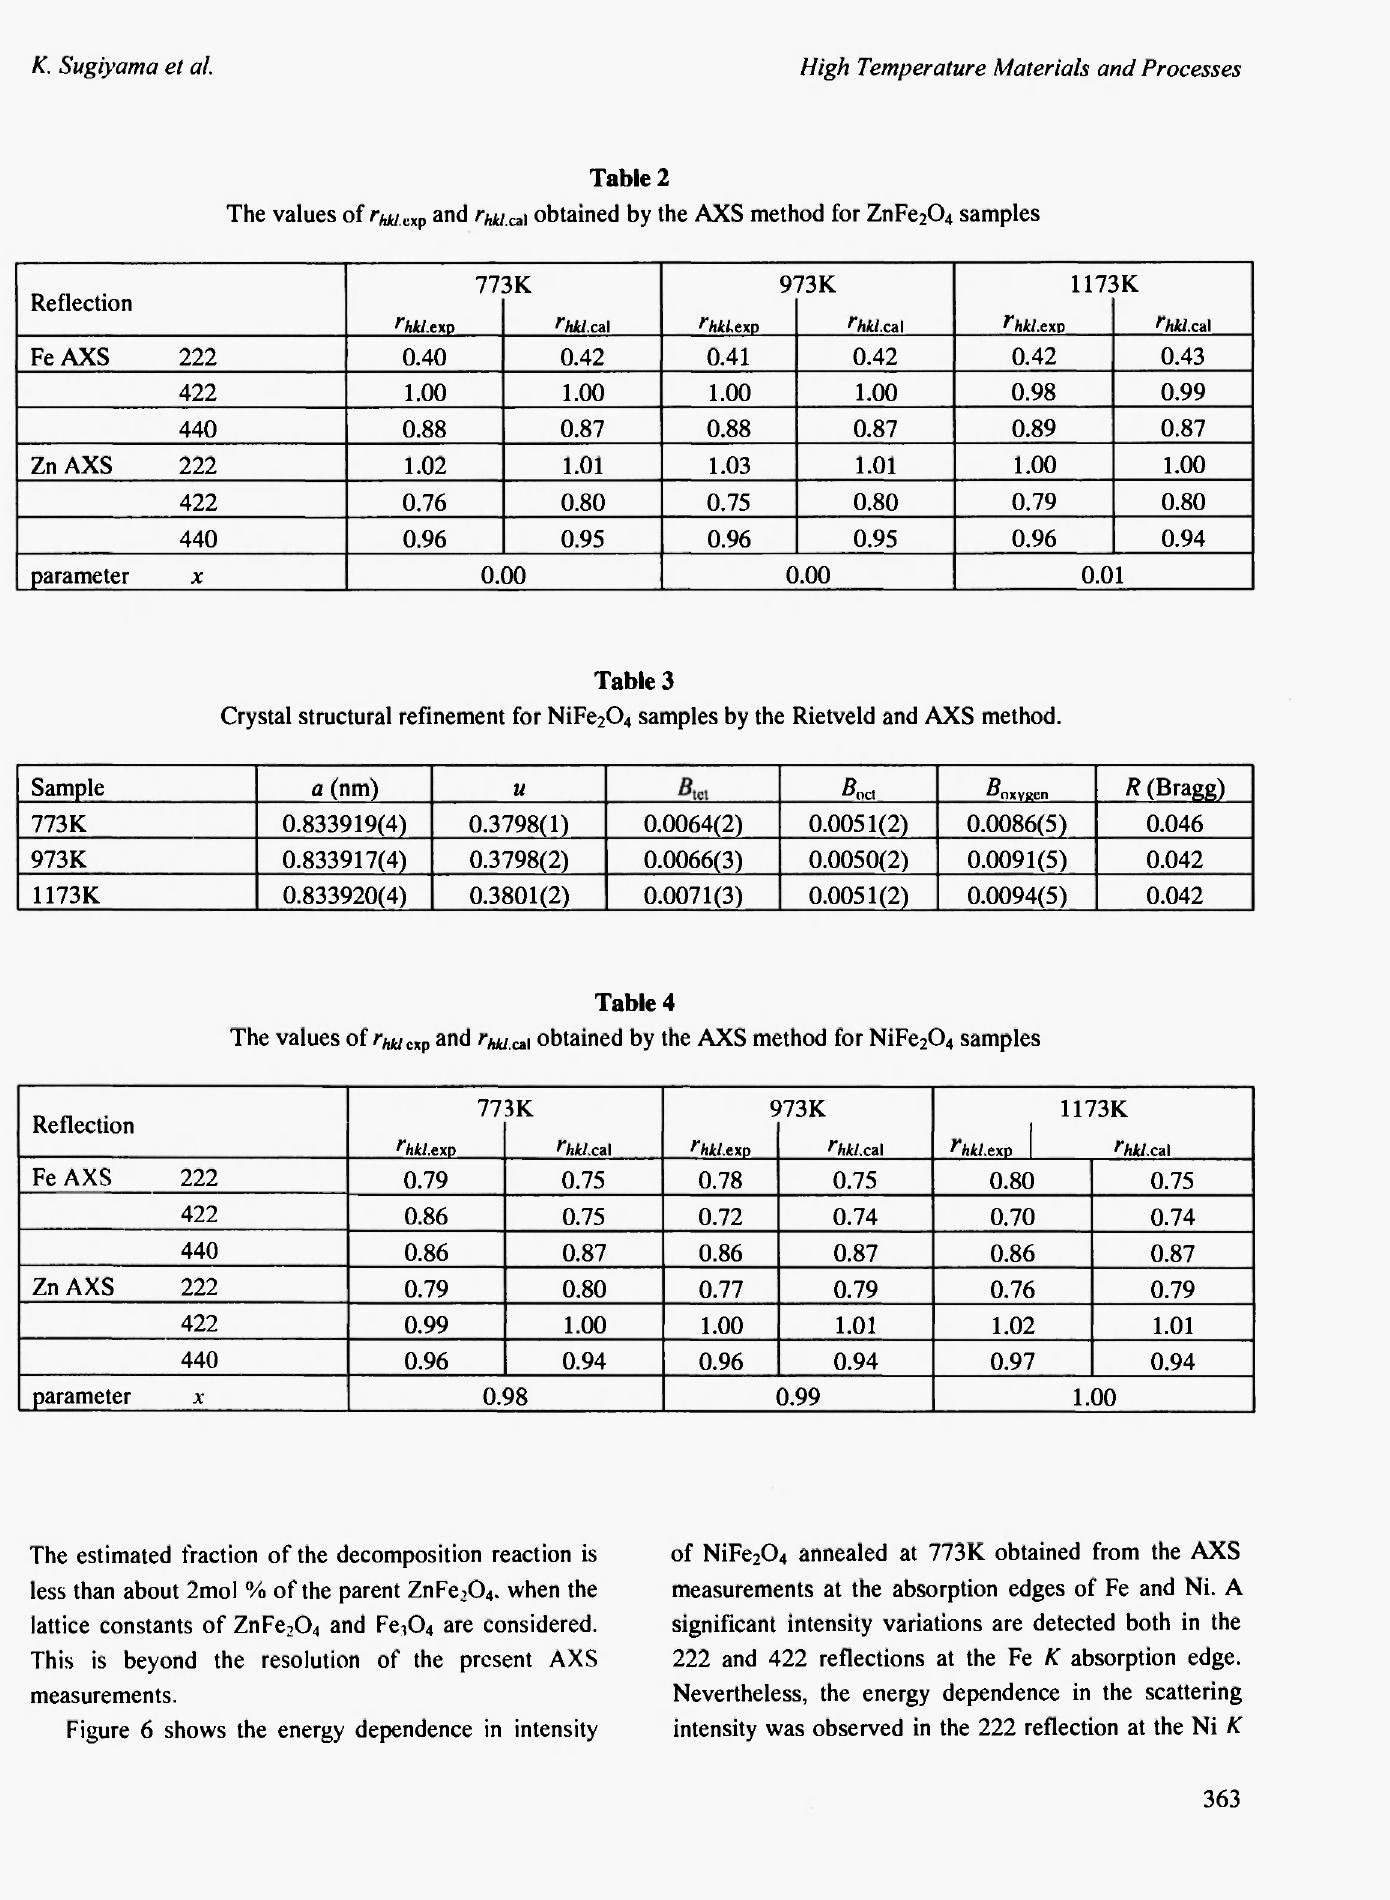
Crystal structural refinement for NiFe 2 0 4 samples by the Rietveld and AXS method.